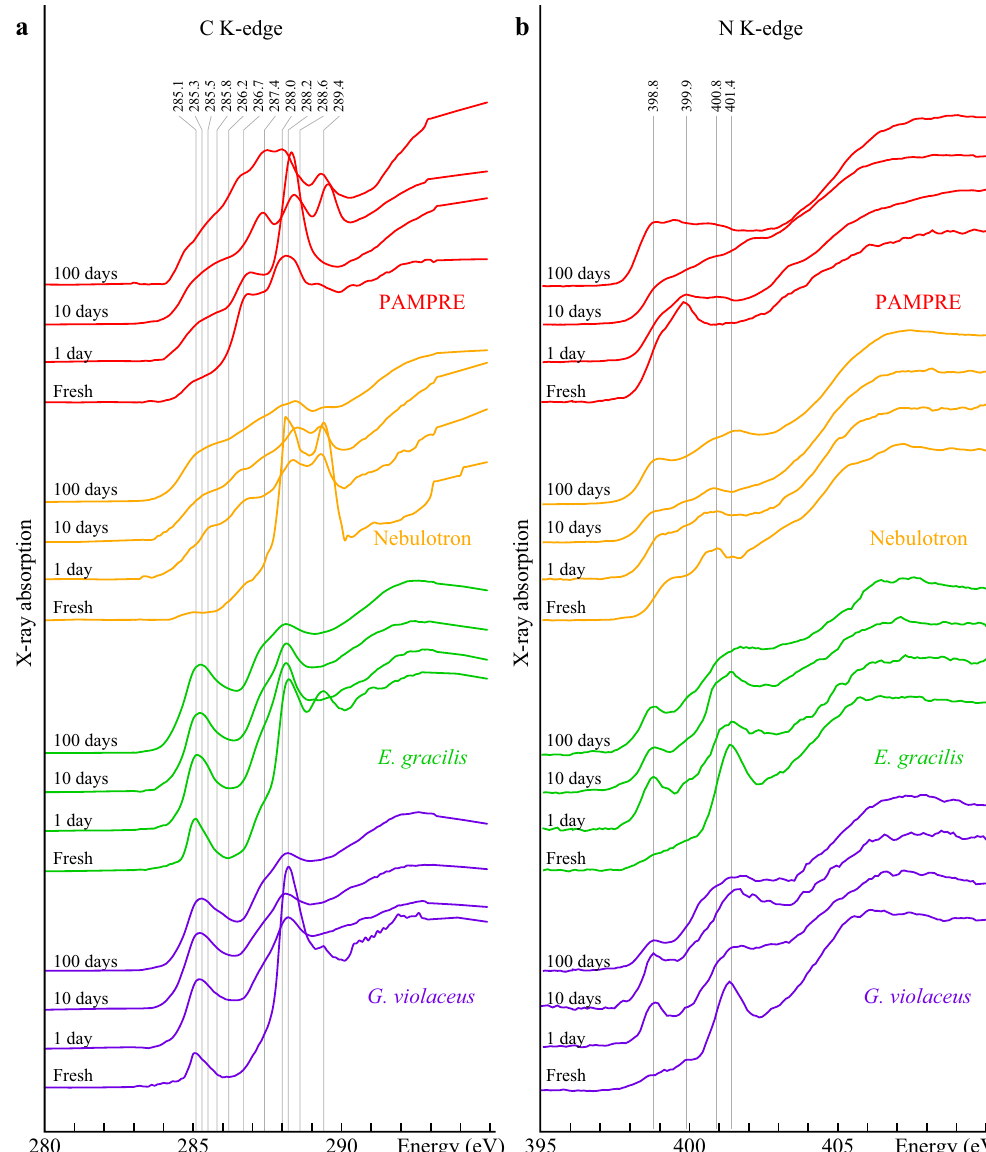
Figure 3. Evolution of XANES signatures. C-XANES ( a ) and N-XANES ( b ) spectra of organic materials and the corresponding residues of the 1, 10 and 100 day long advanced diagenesis experiments performed at 250 °C and 250 bars. Attribution of absorption features: 285.1 eV: aromatics/olefinics; 285.8–287.4 eV: imines/nitriles/ carbonyls/phenols; 287.5–288.0 eV: aliphatics; 288.2 eV: amides; 288.6 eV: carboxyls/esters/acetals; 289.4 eV: hydroxyls; 398.8–399.9 eV: imines/nitriles/pyridines; 400.8/401.4 eV: